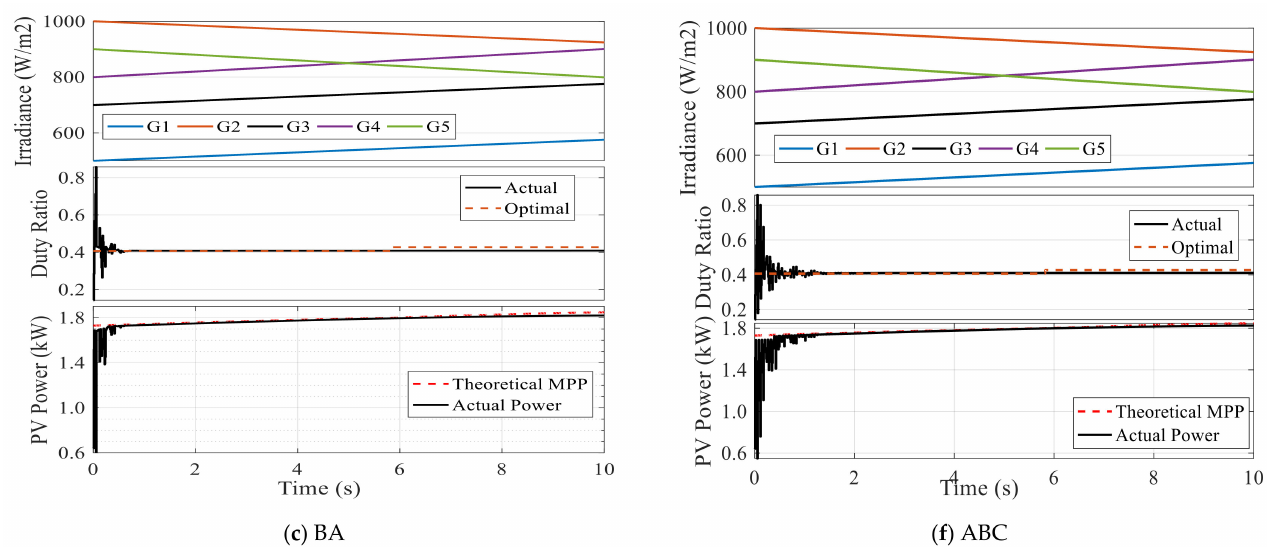
Figure 12. The performance of optimization techniques under study with continuous change of radiations.